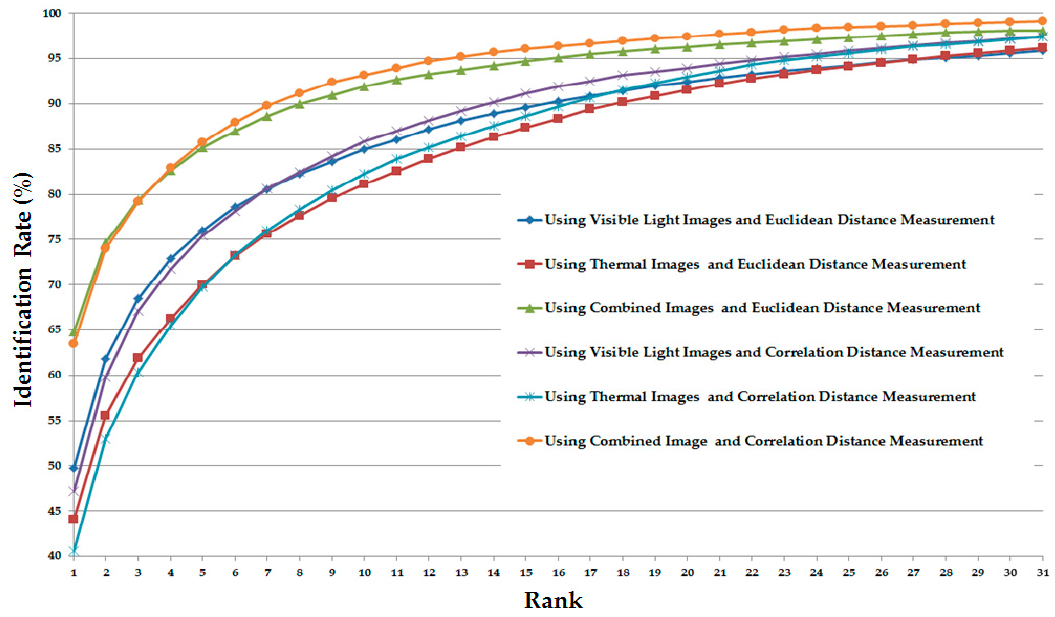
Figure 19. CMC curves of the identification systems that use the leg part for the identification problem.